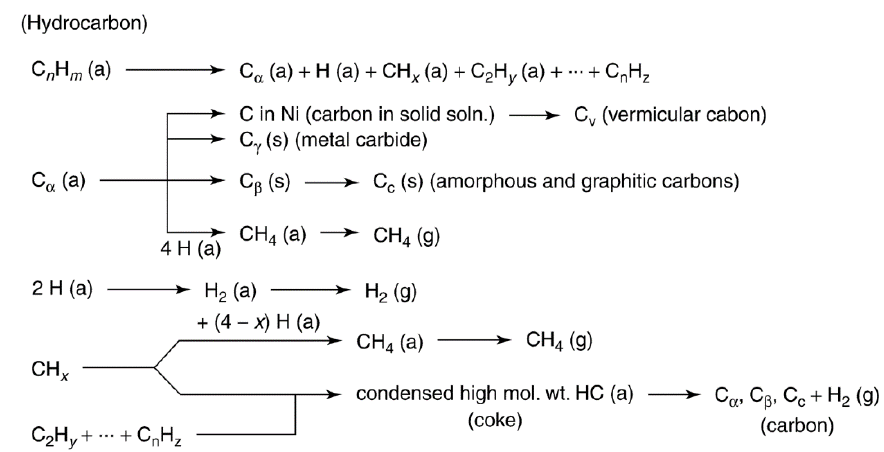
Figure 11. Formation, transformation, and gasification of carbon on nickel (a, g, s refer to adsorbed, gaseous, and solid states respectively). Reproduced from [60]. Copyright 1983, Elsevier.